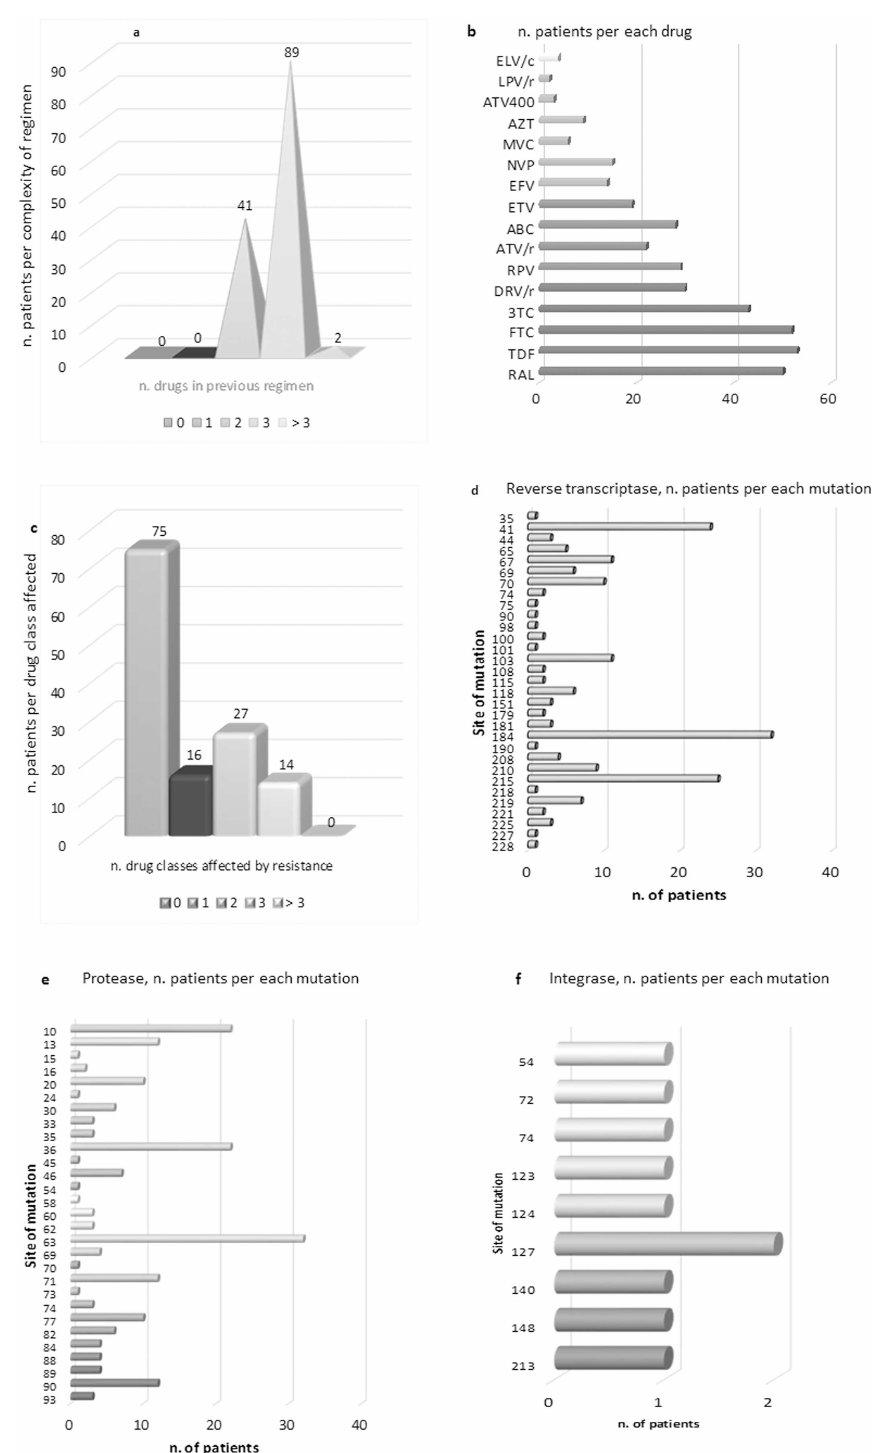
Fig 1. Patients’ baseline disposition towards antiretrovirals was based on: a) the complexity of the former regimen; b) the frequency of single antivirals in the former regimens of the population; c) the complexity of drug resistance at baseline; d), e), f) the frequency of single baseline mutations in the population by reversetranscriptase, protease and integrase regions, respectively. ELV/ c = elvitegravir/cobicistat, AZT = zidovudine, LPV = lopinavir,/r = boosted with ritonavir, ATV =